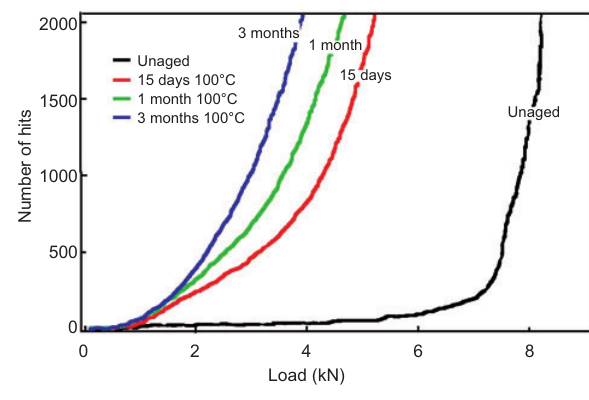
Figure 6 Compression curves of MS1 aged at 100 ° C.